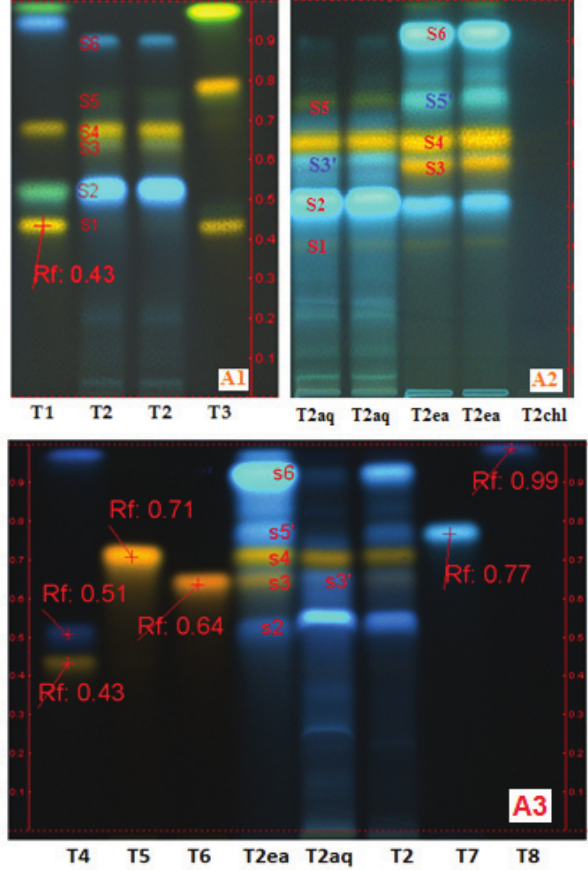
Figure 1: TLC aspects of Arctium lappa folium extracts comparatively to the reference substances (ref.). A1: Track T1, quercetin-3-O- rutinoside/ rutin, chlorogenic acid, apigenin-7-O-apiosyl-glucoside/ apiin, quercetin-3-O-galactoside/ hyperoside, rosmarinic acid, and apigenin (ref); Tracks T2, burdock leaves whole (70%, v/v) ethanol extract/W – duplicate sample; Track T3, rutin, vitexin-2’’- O-rhamnoside, luteolin-7-O-glucoside/ cynaroside,